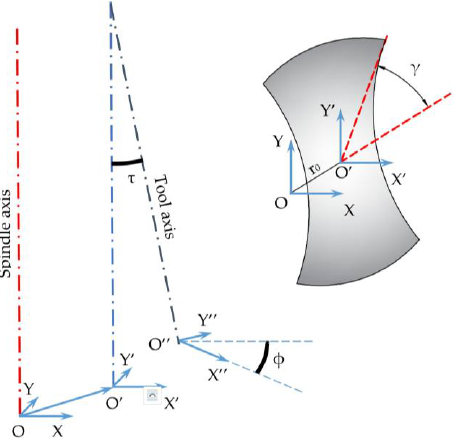
Figure 1. Tool run-out and its geometric parameters.